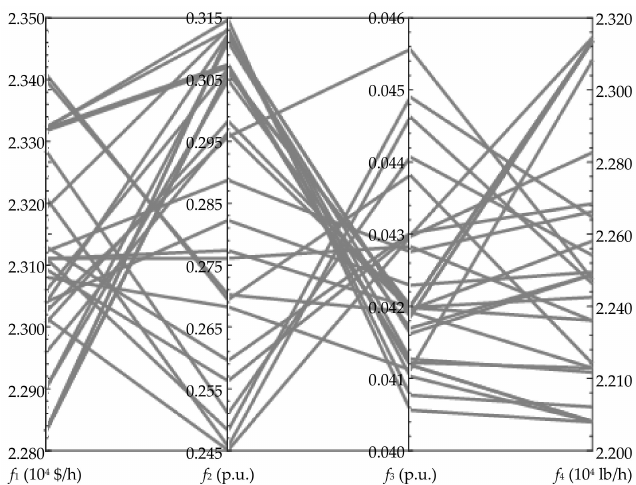
Figure 3. Distribute condition of Pareto-optimal solutions of reference vector guided evolutionary algorithm (RVEA).